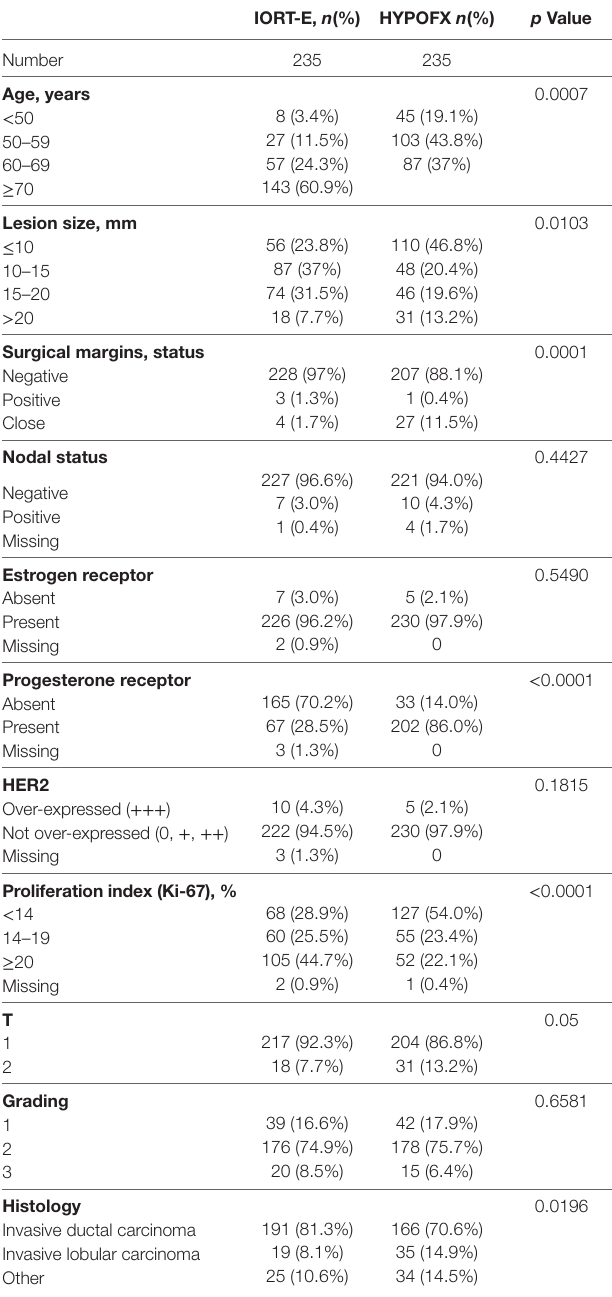
TaBle 1 | Characteristics of patients in intraoperative radiation therapy with an electron beam (IORT-E) group and HYPOFX